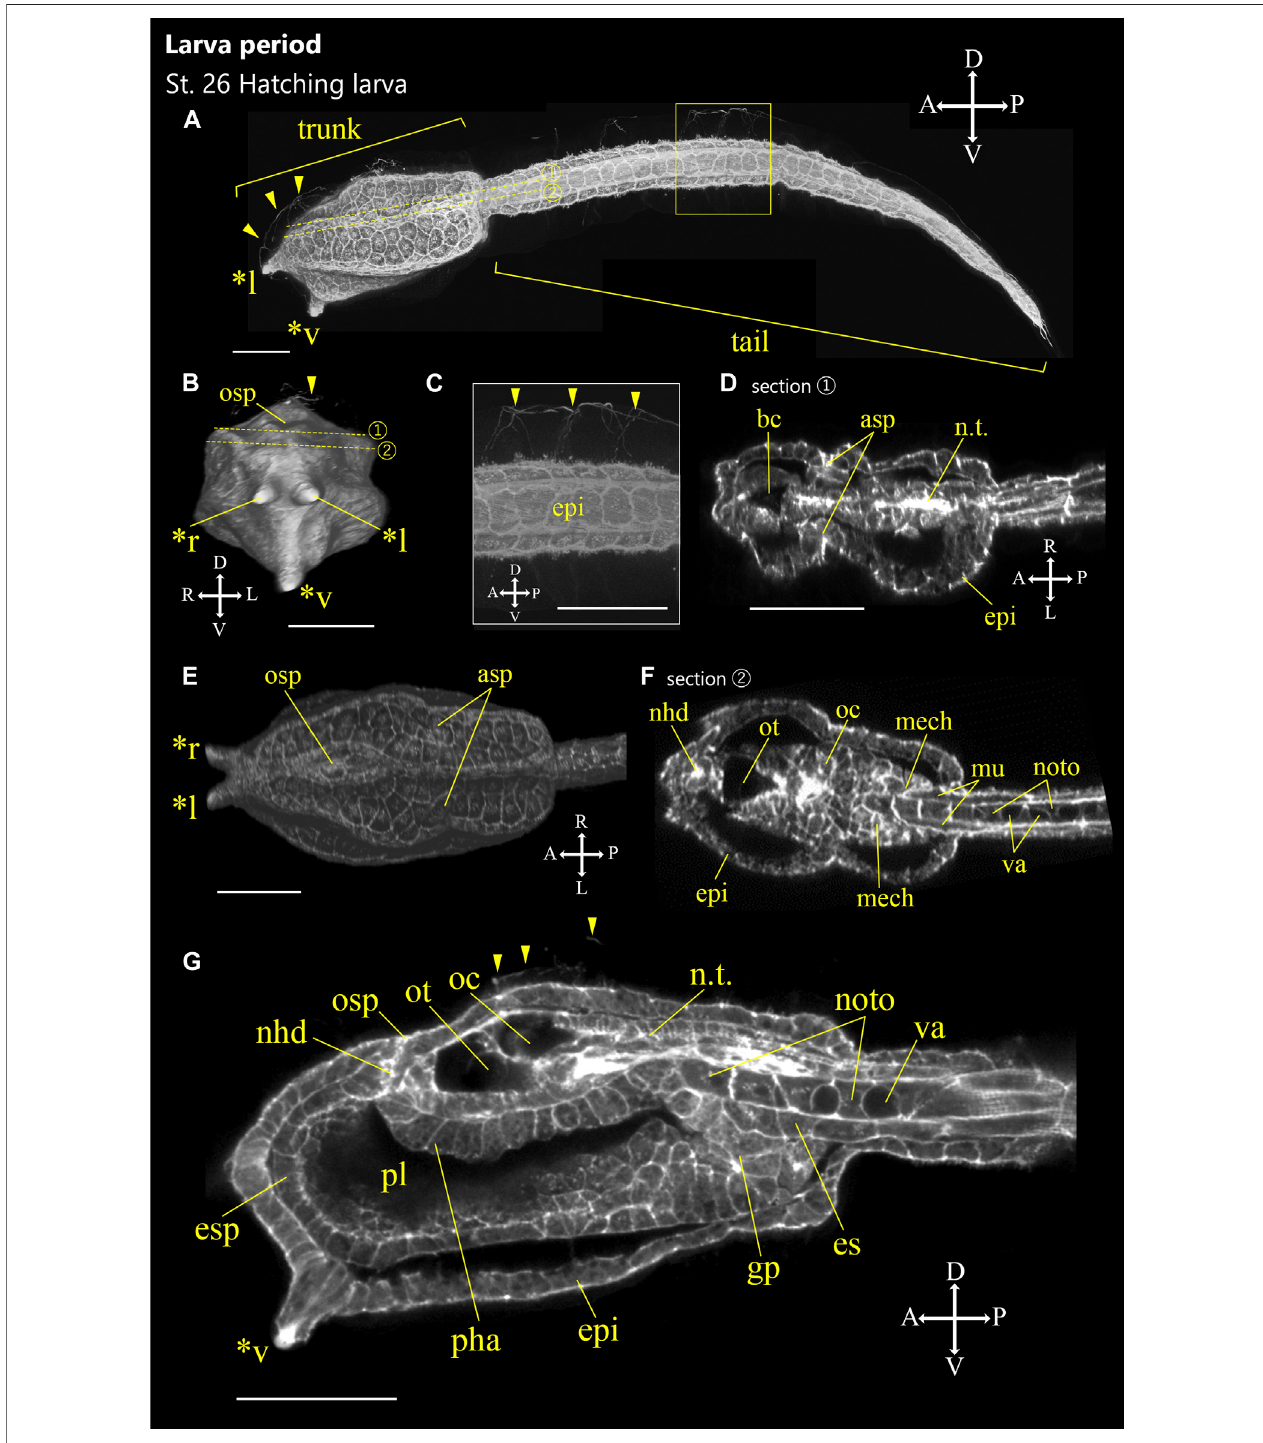
FIGURE8| Ascidiella aspersa embryosattheinitialpartoflarvaperiod.EmbryoswerestainedwithAlexaFluor ™ 546Phalloidin.Three-dimensionalreconstructed imagesat (A) Stage 26(hatchinglarva). (A) Lateral viewoftheembryo. (B) Frontalviewoftheembryo. (C) Enlargedimageoftheareainsidetheyellow framein (A) . (D,F) Cross-section ofthetrunk.Thepositionsofthesections areindicatedbydashed lines in (A,B) . (E) Dorsalviewofthetrunk. (G) Longitudinalsectionofthetrunk.Embryo directionisshownbyA,anterior;P,posterior;D,dorsal;V,ventral.Arrowheadsindicatetheciliaofepidermalsensoryneurons.Asterisksindicatesthepapillaeby*l: left papilla, *r: right papilla, *v: ventral papilla. asp, atrial siphon primordium; bc, brain cavity; en, endoderm; epi, epidermis; es, endodermal strand; gp, gut primordium; mech:mesenchyme;mu,muscle;nhd,neurohypophysealduct;noto, notochord;n.t.,neuraltube; oc,ocellus;osp,oralsiphonprimordium;ot,otolith; pha ,pharynx;pl, preoral lobe; and va, vacuole. Scale bar: 50 μ m.